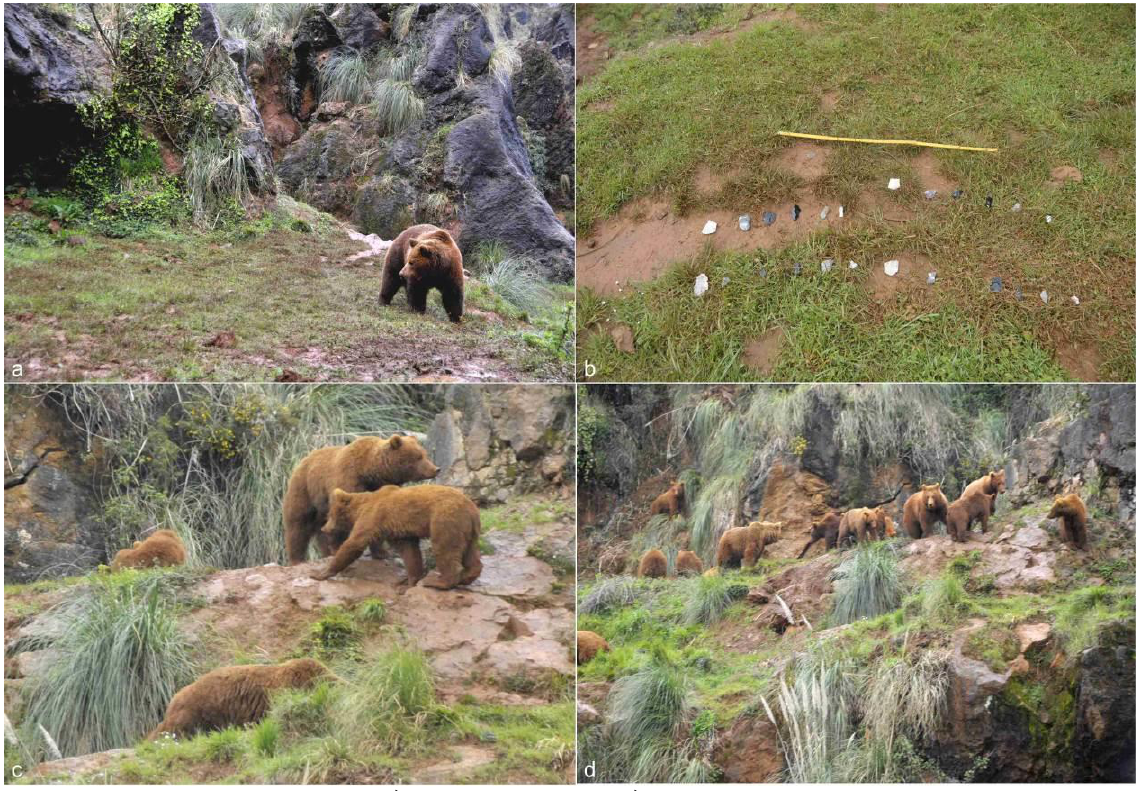
Fig. 3 - Bear trampling experiment: a) area of experiment; b) experimental pieces in experimental area at the start of experiment; c and d) area of experiment 15 to 30 minutes after the experiment had